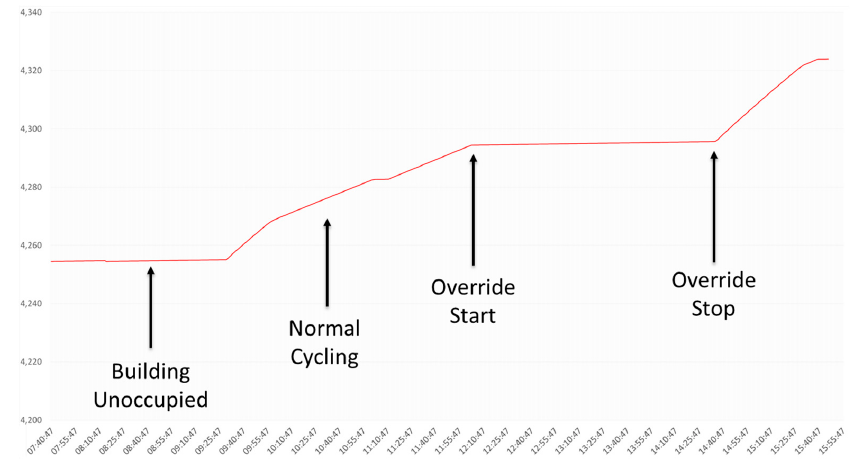
Figure 5. Measured chiller electricity consumption (KWh).